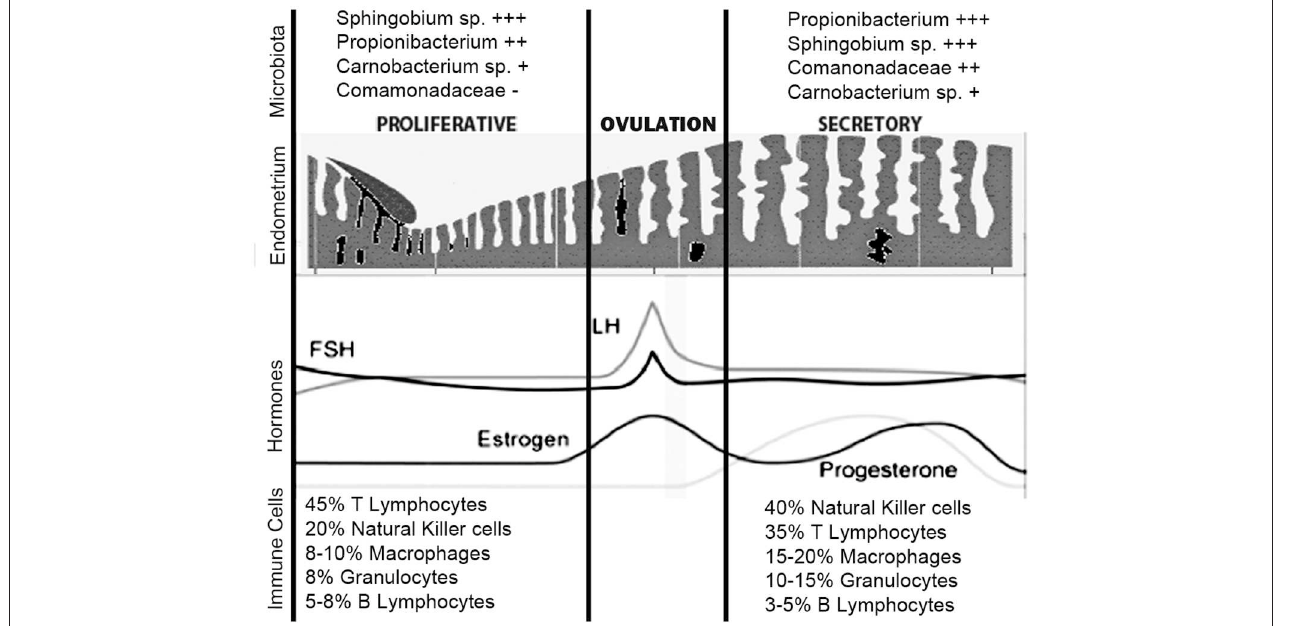
FIGURE 3 | Uterine immune stages during menstruation cycle. During the normal menstrual cycle, the human endometrium is exposed to cyclical fluctuations of sex hormones. The repetitive cycles of proliferation, differentiation, decidualization, and shedding of this tissue during mensuration and the steroid hormones per se cause profound changes in the immune cells’ population. The estrogen-dominant proliferative phase is characterized by the regeneration of the functional layer of the endometrium. In the progesterone driven secretory phase, the endometrium undergoes a number of changes in preparation for implantation of the embryo. The immune cells that undergo greater number variations in the secretory phase are the NKs and macrophages. The microbiota, on the other hand, does not undergo large variations during different phases of the menstrual cycle. Sphingobium sp., Propionibacterium acnes, and Pseudomonas sp. are differentially enriched during the proliferative and secretory phases; P. acnes is more abundant in the secretory phase and has previously been identified in the placenta and cultured from follicular fluid. Functionally, the proliferative phase, compared to the secretory phase, appears associated with increased bacterial proliferation. + + ++/+ represent the relative abundance amount of